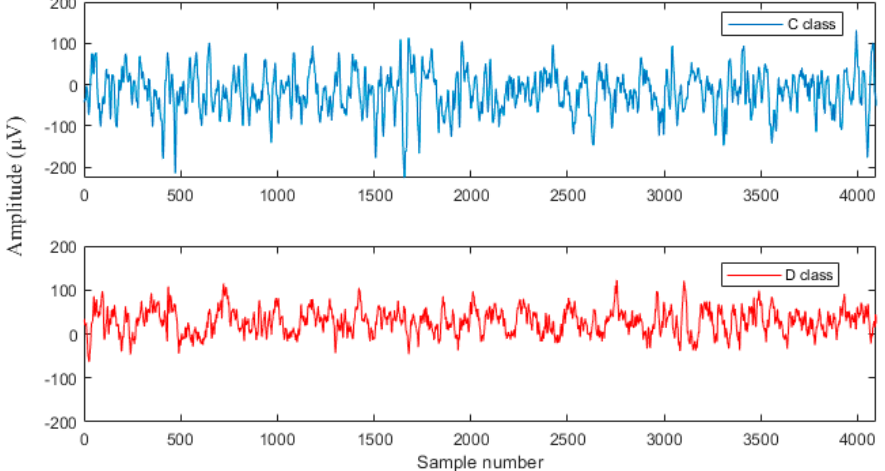
Figure 1. Sample of University of Bonn dataset.